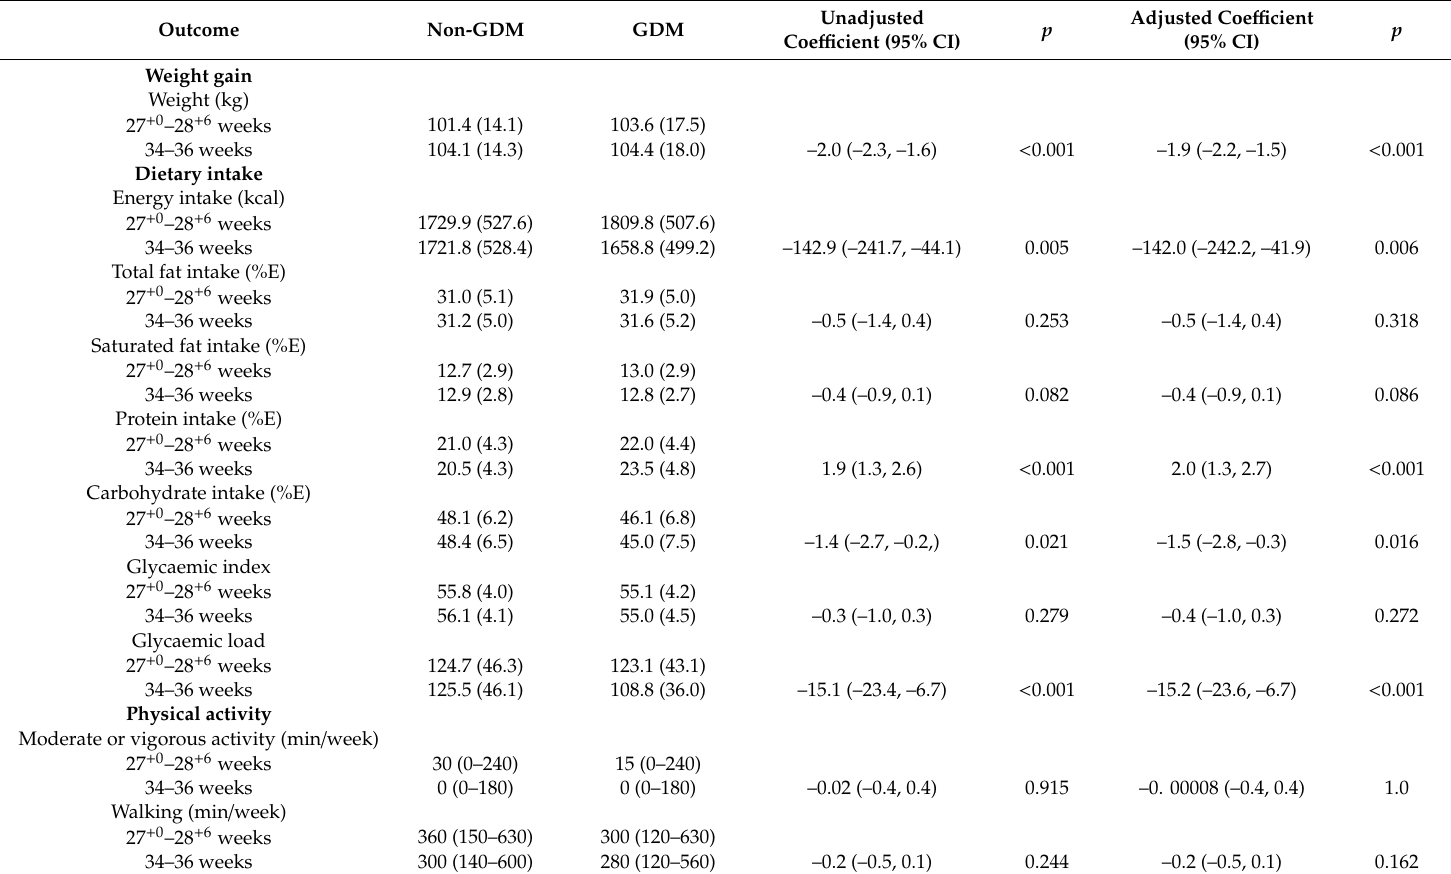
Table 2. Weight gain, dietary intake and physical activity outcomes for the GDM and non-GDM women by gestational period, and unadjusted and adjusted linear regression models examining the association between GDM diagnosis and change in each outcome variable between 27 + 0–28 + 6 weeks’ and 34–36 weeks’